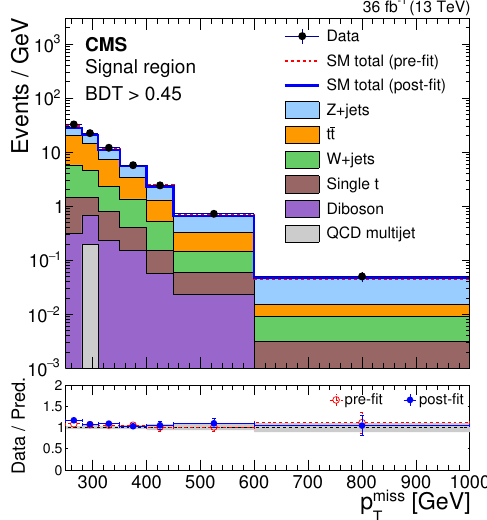
Figure 17 . Distribution of p miss from SM backgrounds and data in the tight category of the signal T region after (cid:12)tting the control regions only. Each bin shows the event yields divided by the width of the bin. The stacked histograms show the individual SM background distributions after the (cid:12)t is performed. The lower panel of the (cid:12)gure shows the ratio of data to (cid:12)tted prediction. The gray band on the ratio indicates the one standard deviation uncertainty on the prediction after propagating all the systematic uncertainties and their correlations in the (cid:12)t.